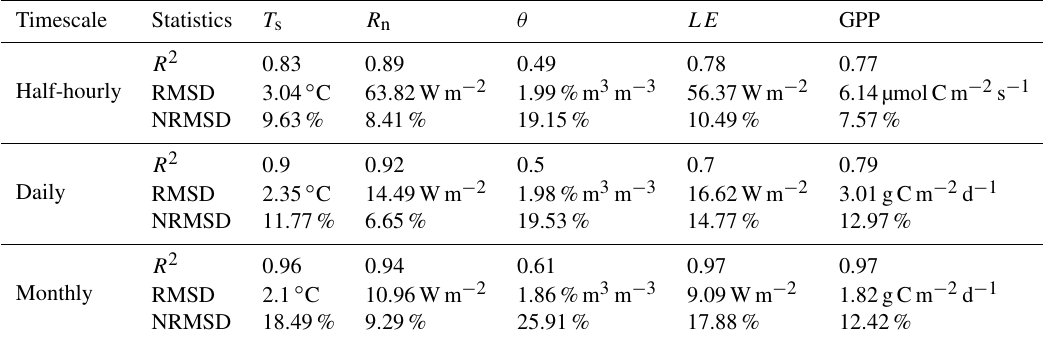
Table 3. Comparison of model simulation performance at half-hourly, daily, and monthly timescales. Timescale Statistics T s R n